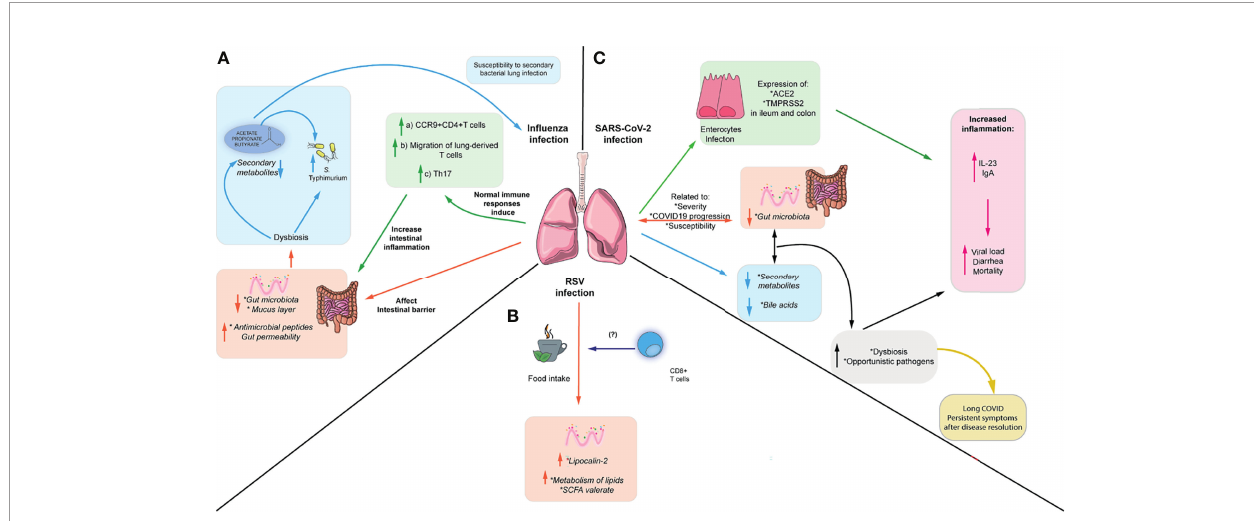
FIGURE 2 | Respiratory viruses affect intestinal immunity and intestinal microbiota. (A) IAV can cause intestinal in fl ammation through the migration of in fl ammatory Th17 cells to the gut, which in turn cause microbiota-dependent in fl ammation. In addition, IAV can cause increased susceptibility to S. Typhimurium infection and increased susceptibility to S. pneumoniae , which can be reversed by administering SCFA. (B) RSV can cause changes in enteric antimicrobial peptides such as lipocalin-2 and low-grade intestinal in fl ammation. Also, it can alter the microbiota and metabolites through the changes in food intake during infection. These changes in food intake have been linked to alterations in CD8 + T cells (C) SARS-CoV-2 can alter the microbiota composition, increasing the abundance of opportunistic pathogens and altering the metabolome. Furthermore, it can directly infect intestinal epithelial cells and affect levels of fecal cytokines, although it is unclear if it can cause intestinal in fl ammation. Moreover, gut dysbiosis and bacterial translocation of opportunistic gut pathogens into the blood have been associated persistent symptoms after disease